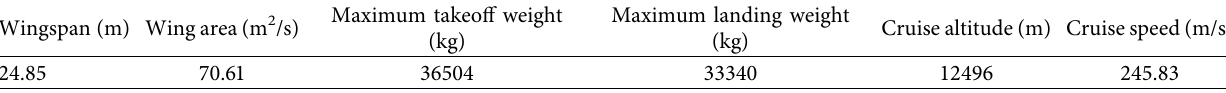
Figure 4: Strip model of wake vortex encountering. (a) Aircraft encountering wake vortex. (b) Discretization of strip method and local airspeed. Table 3: Geometric main dimensions of CRJ-900-700